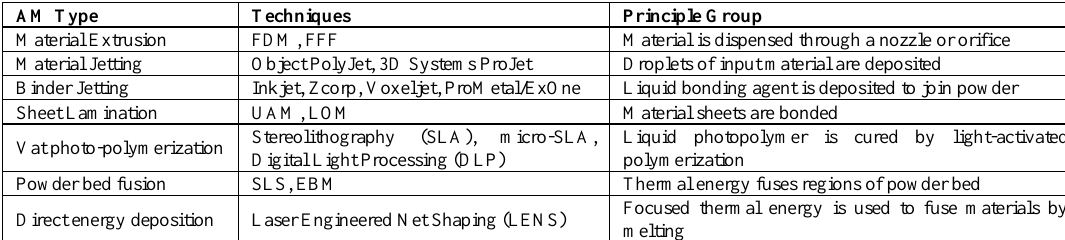
Table 1. Categories of additive manufacturing